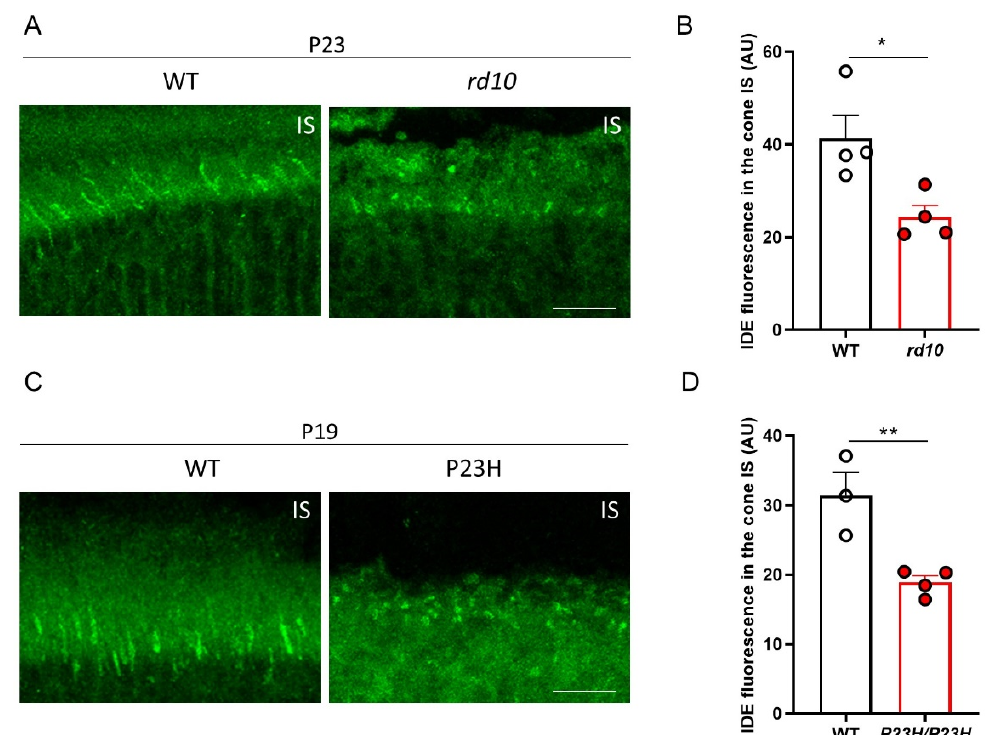
Figure 4. Comparison of IDE expression in the cone IS of wild-type mice and 2 mouse models of retinitis pigmentosa. ( A , C ) Images showing WT and rd10 retinal sections at P23 ( A ) and WT and P23H/P23H retinal sections at P19 ( C ) immunostained for IDE (green). ( B , D ) Quantification of IDE fluorescence intensity in the cone IS in WT and rd10 retinas at P23 ( B ) and WT and P23H/P23H retinas at P19 ( D ). n = 3–4 individual retinas from 3–4 mice. ** p < 0.01; * p < 0.05 (unpaired 2-tailed Student’s t -test). IS, inner segment; AU, arbitrary units. Scale bars: 13 μ m.